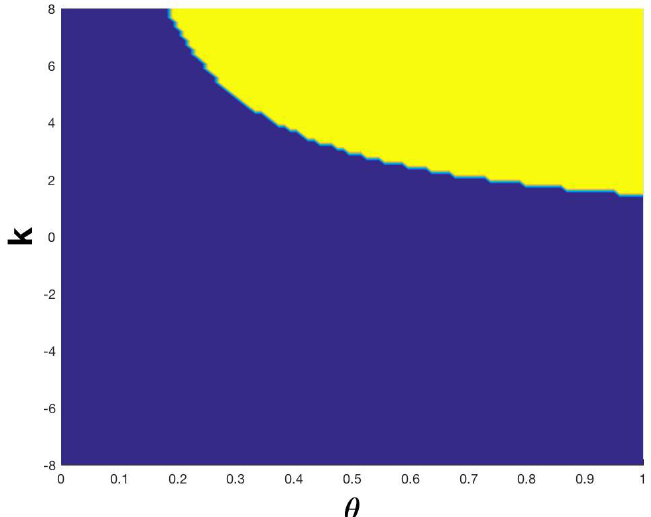
Figure 4. Allee effect in the deterministic system (59): The yellow area represents the area where 0 is stable for this system, whereas the blue one depicts the area where 0 becomes